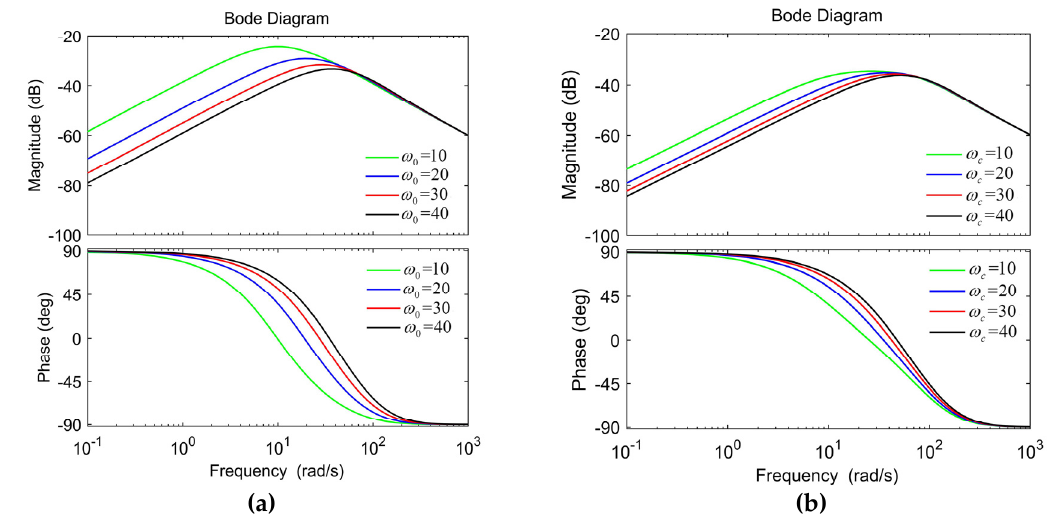
( ) Y s Figure 6. Simplified system structure. Taking